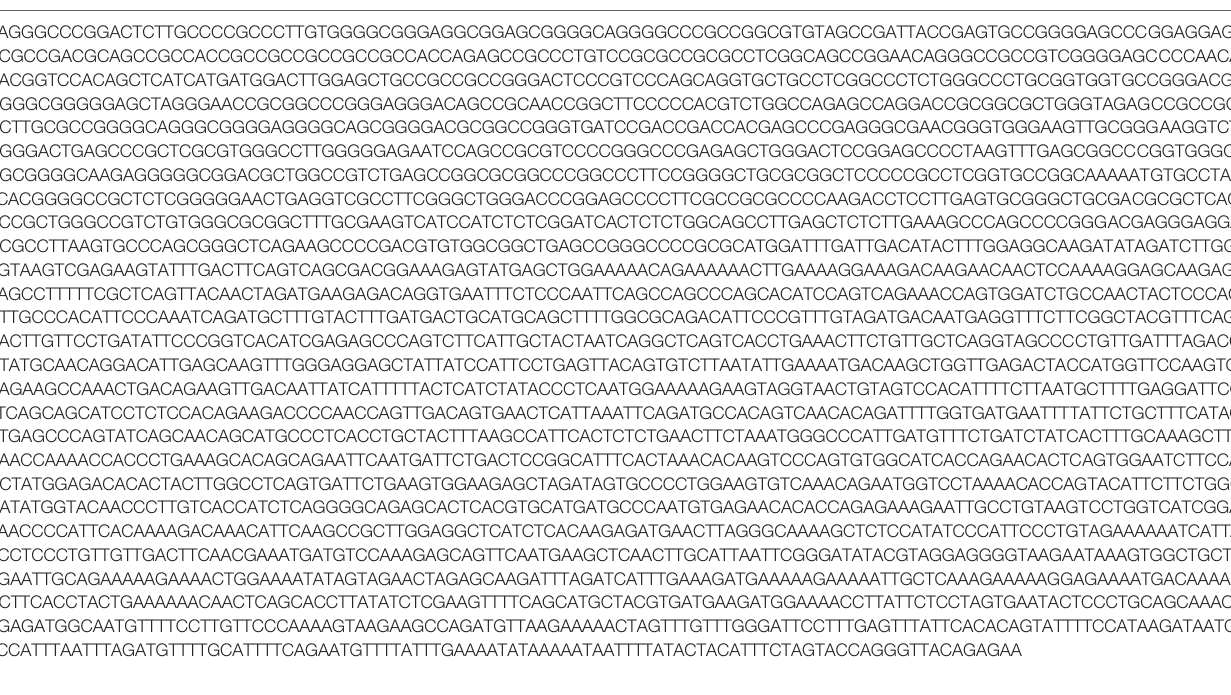
TABLE 1 | NRF2 promoter sequence including 1,000 bases upstream, CDS exons, and 150 bases